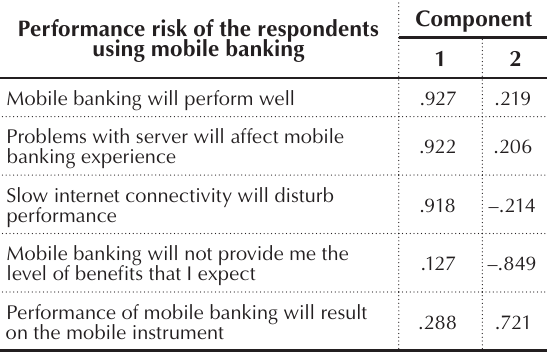
Table 10. (cid:38)(cid:258)(cid:272)(cid:410)(cid:381)(cid:396)(cid:3)(cid:258)(cid:374)(cid:258)(cid:367)(cid:455)(cid:400)(cid:349)(cid:400)(cid:3)(cid:381)(cid:374)(cid:3)(cid:410)(cid:346)(cid:286)(cid:3)(cid:393)(cid:286)(cid:396)(cid:296)(cid:381)(cid:396)(cid:373)(cid:258)(cid:374)(cid:272)(cid:286)(cid:3)(cid:396)(cid:349)(cid:400)(cid:364)(cid:3) (cid:381)(cid:296)(cid:3)(cid:410)(cid:346)(cid:286)(cid:3)(cid:396)(cid:286)(cid:400)(cid:393)(cid:381)(cid:374)(cid:282)(cid:286)(cid:374)(cid:410)(cid:400)(cid:3)(cid:437)(cid:400)(cid:349)(cid:374)(cid:336)(cid:3)(cid:373)(cid:381)(cid:271)(cid:349)(cid:367)(cid:286)(cid:3)(cid:271)(cid:258)(cid:374)(cid:364)(cid:349)(cid:374)(cid:336)